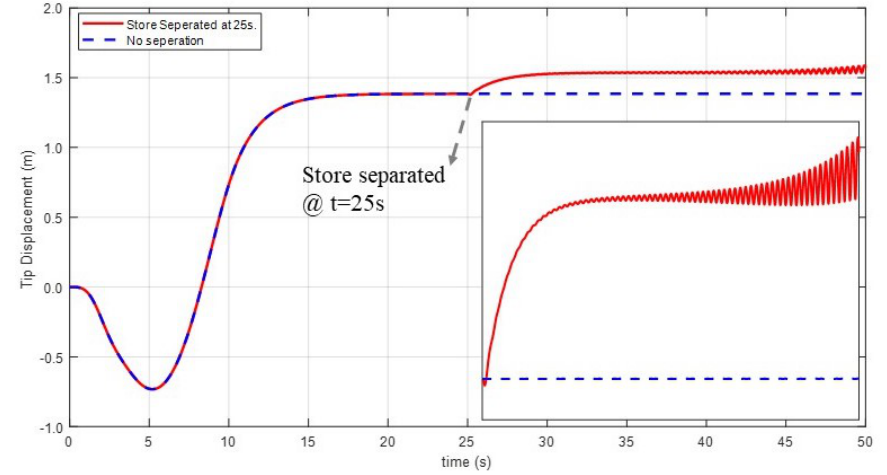
Figure 7. Tip response after store separation as compared to the no-separation